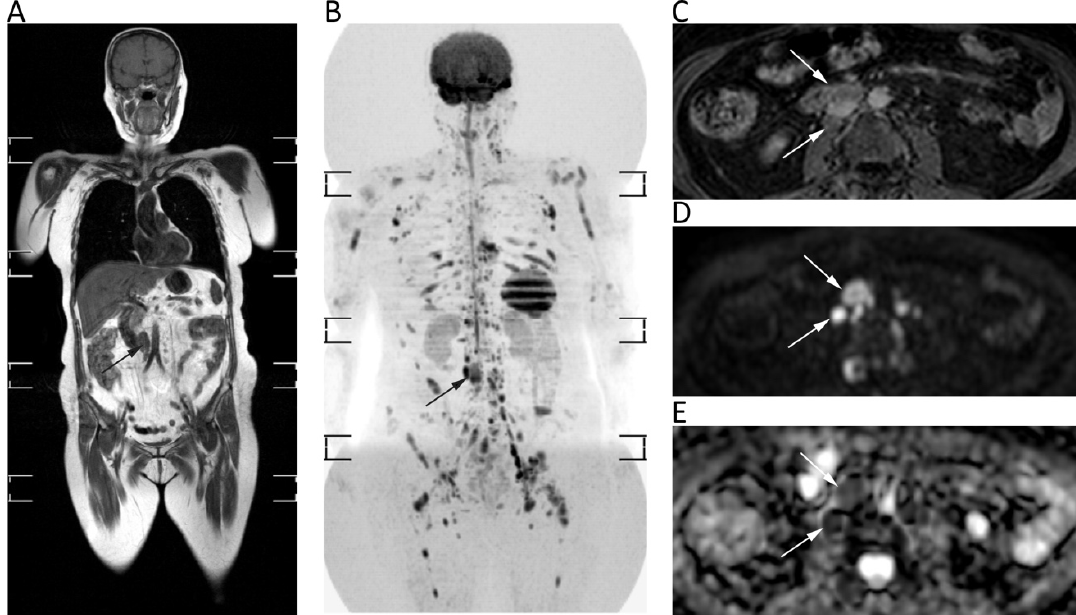
Figure 11. Whole-body MRI of a 58-year-old female patient with non-Hodgkin lymphoma. Whole-body T1w ( A ) and coronal MIP grey-scale inverted DWI ( B ) show multiple nodal and bone locations of disease. Note the periaortic lymph nodal locations (arrows) with moderate contrast enhancement on axial fat-suppressed 3D GRE T1w ( C ) and restricted pattern of diffusion on axial b = 800 DWI ( D ) and corresponding ADC map ( E , mean ADC: 0.761 × 10 − 3 mm 2 /s).